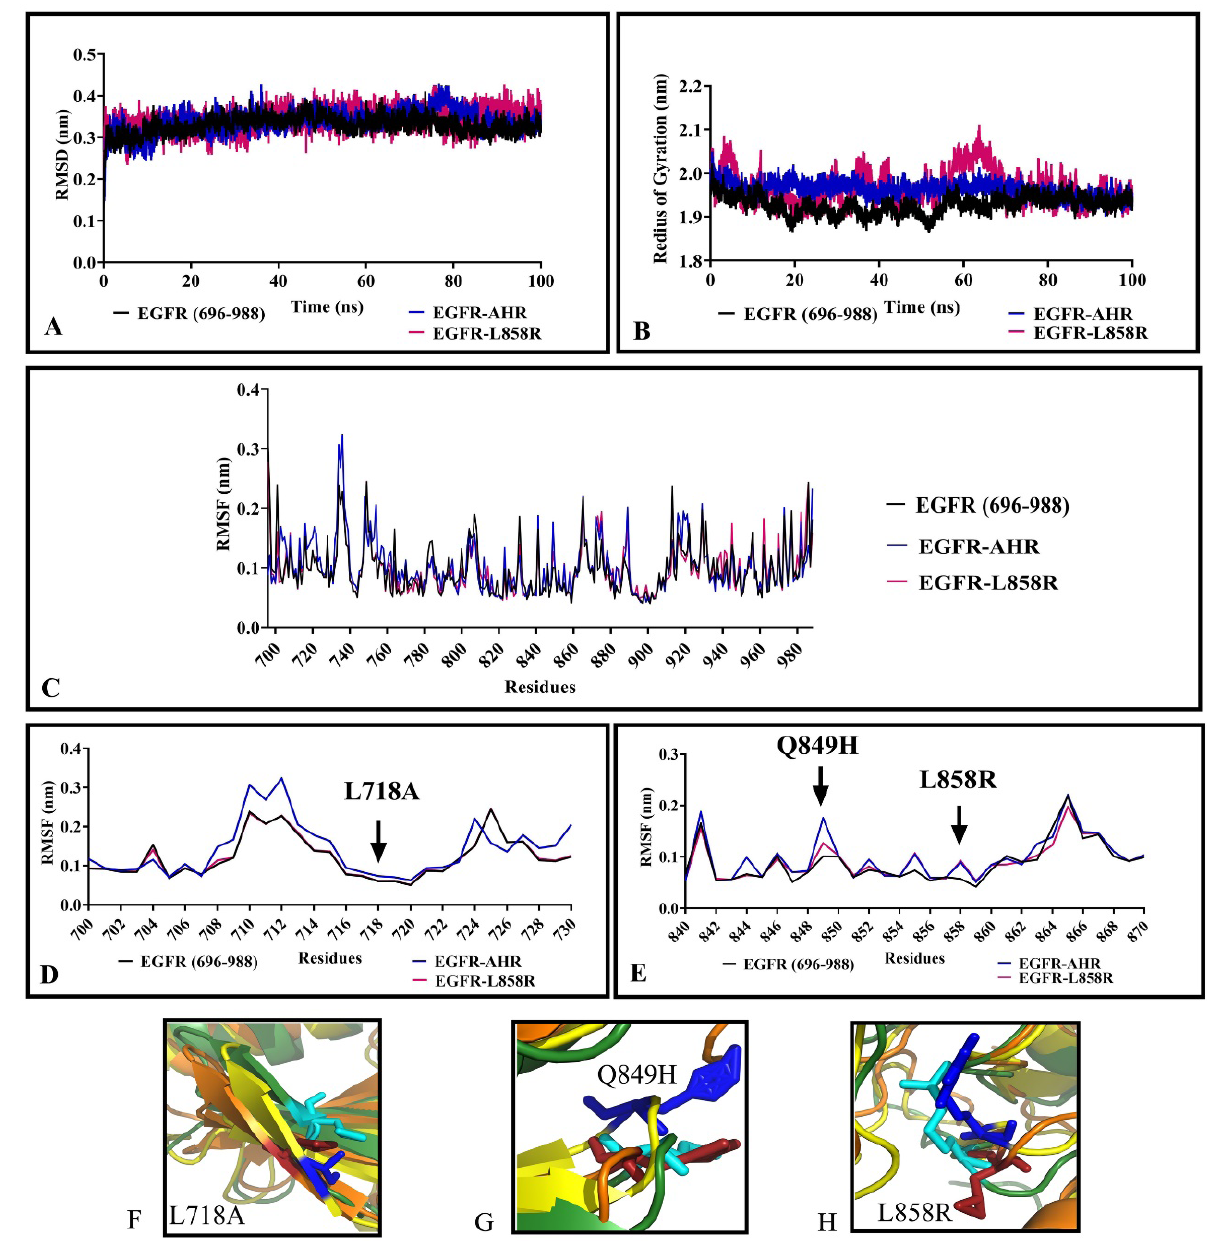
Figure 1: Analysis of MD simulations for wild-type and mutant forms of EGFR. ( A ) RMSD and ( B ) Rg plot for EGFRs. The plots of the wild-type, the triple mutant form (EGFR-AHR), and EGFR-L858R are colored in black, blue, and pink, respectively. ( C ) RMSF values of EGFRs ’ residues during simulations. ( D ) Zoom-in the RMSF values of residues 700-730. ( E ) Zoom-in the RMSF values of residues 840-870. Cartoon view of the superimposition of the wild-type, EGFR-AHR, and EGFR-L858R 3D structures for variants including ( F ) L718A, ( G ) Q849H, and ( H ) L858R. Wild- type, EGFR-AHR, and EGFR-L858R residues are colored in red, blue, and, cyan,